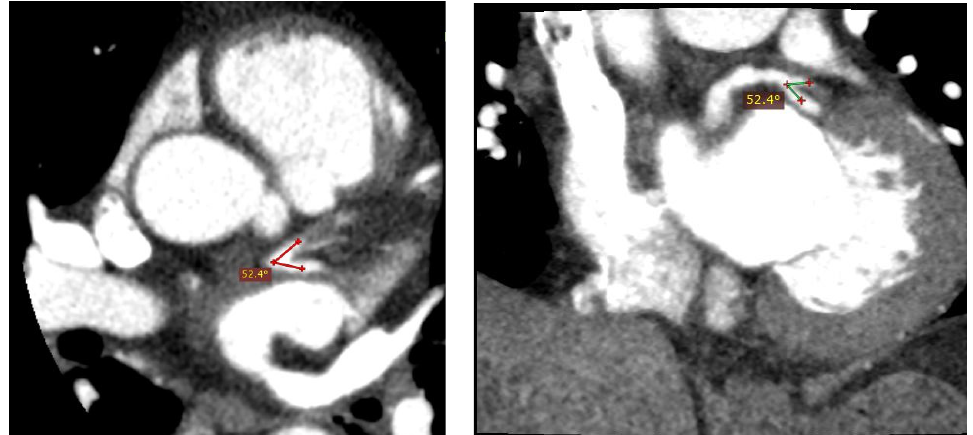
Figure 1. Narrow LAD-LCx angle in a 50-year male patient with no coronary artery disease. The LAD-LCx angle was measured 52.4° on 2D axial image ( left image) and multiplanar reformatted view ( right image).